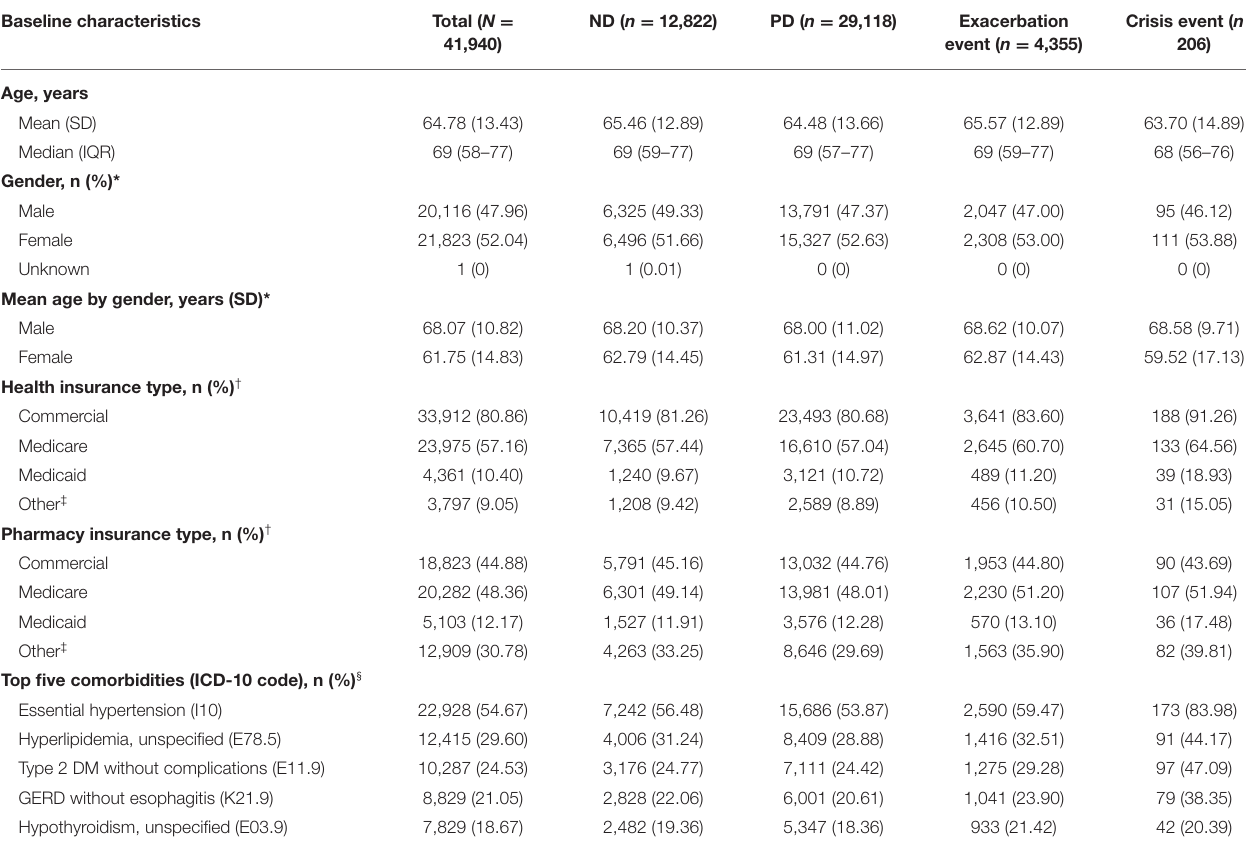
TABLE 1 | Baseline patient demographic and clinical characteristics at index date. Baseline